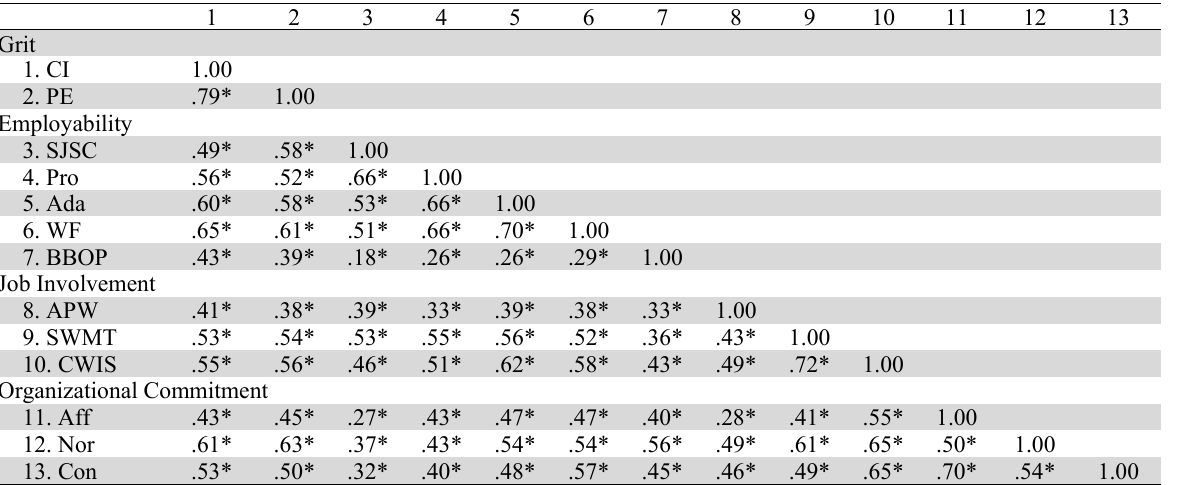
Correlation matrix of